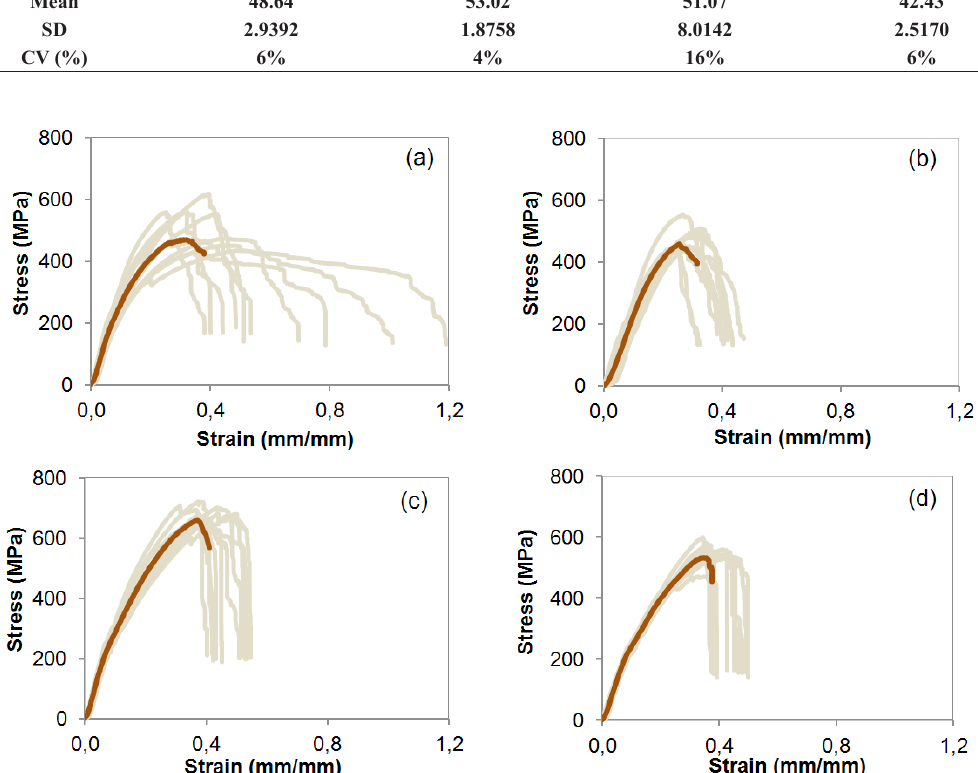
Figure 6- Average stress-strain curve: macrofibre A (normal conditions) a); macrofibre A (mixed conditions) b); macrofibre B (normal conditions) c); macrofibre B (mixed conditions)